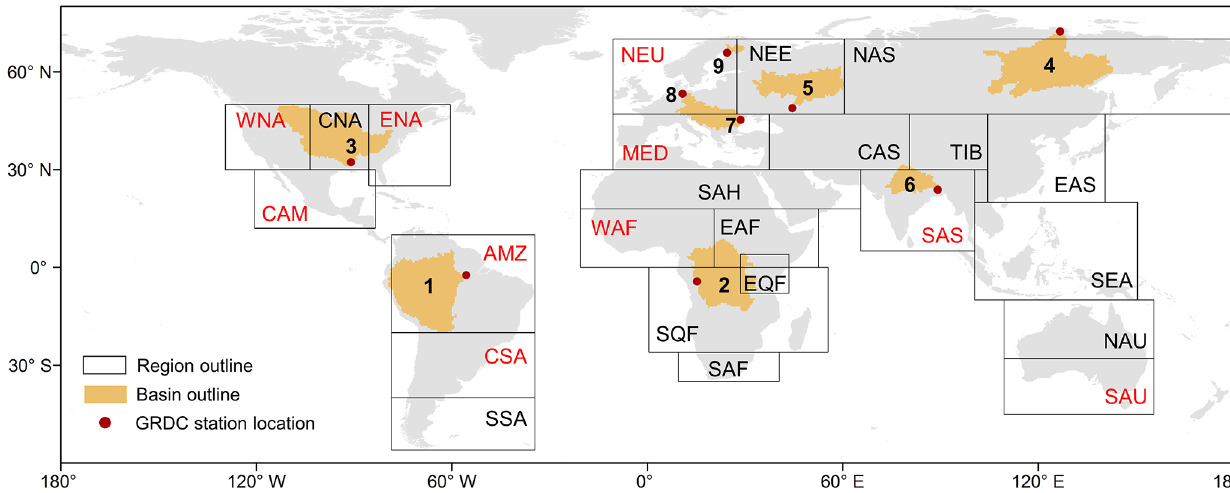
Figure 1. Outlines of study focus regions and hydrological basins and locations of the GRDC gauging stations. With red colour are denoted the regions selected for more detailed analysis. The hydrological basins have been numbered in decreasing order according to their area: